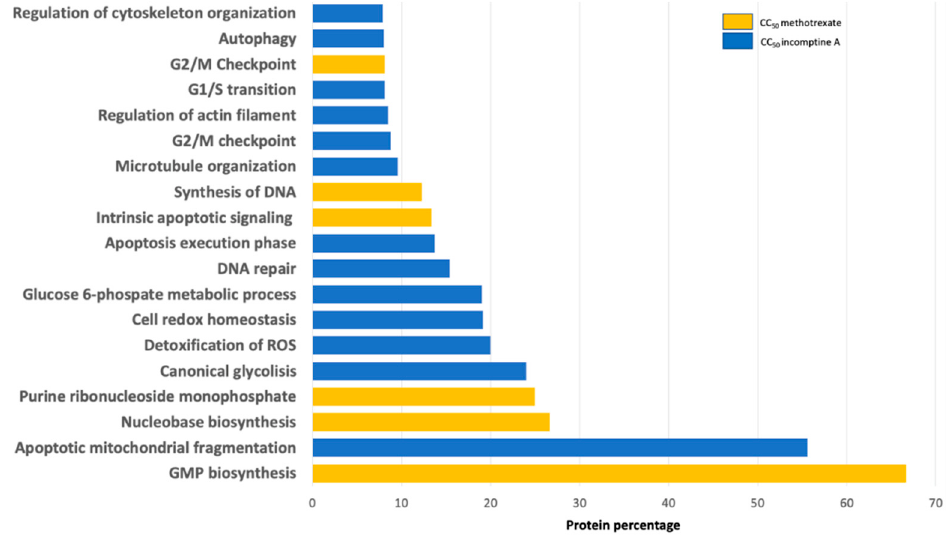
Figure 4. Functional enrichment analysis. Enrichment analysis revealed 82 significantly enriched biological processes and signaling pathways ( p < 0.05). Intrinsic apoptosis can be found in incomptine A and methotrexate treatments, but different biologic processes are differentially expressed.